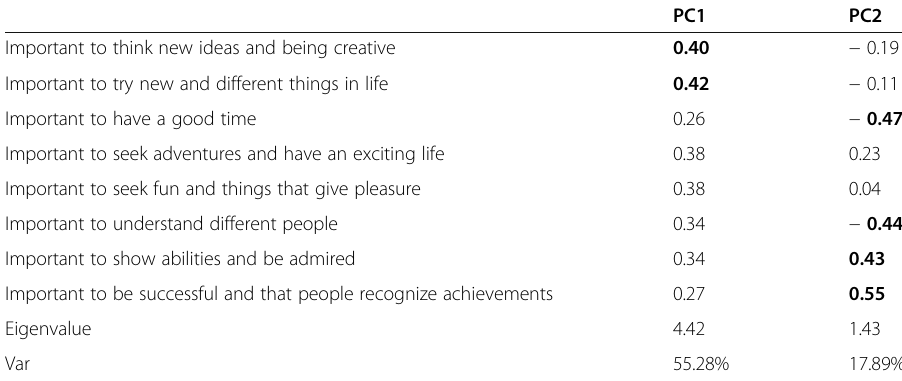
PC1 PC2 0.40 − 0.19